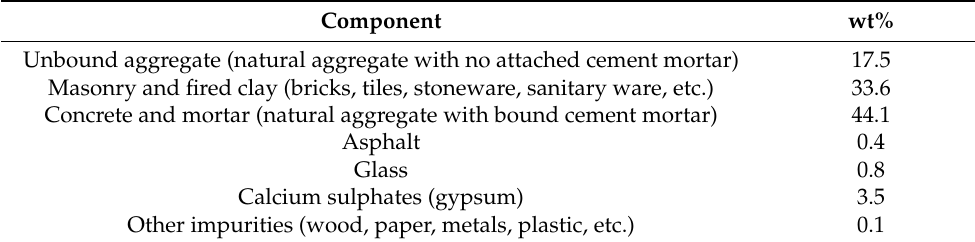
Table 2. Mixed recycled aggregate